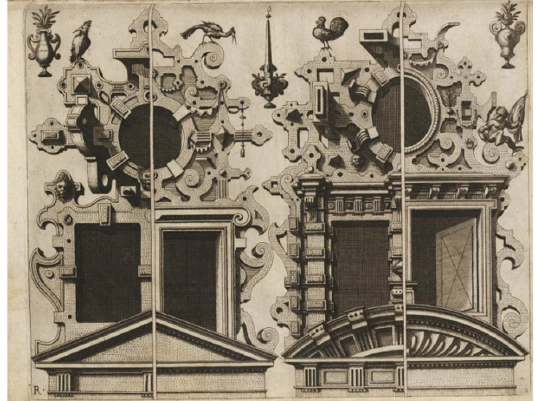
Figure 24. Designs for window casings from the treatise by Hans Vredeman de Vries. Source: Vries, p. 39.